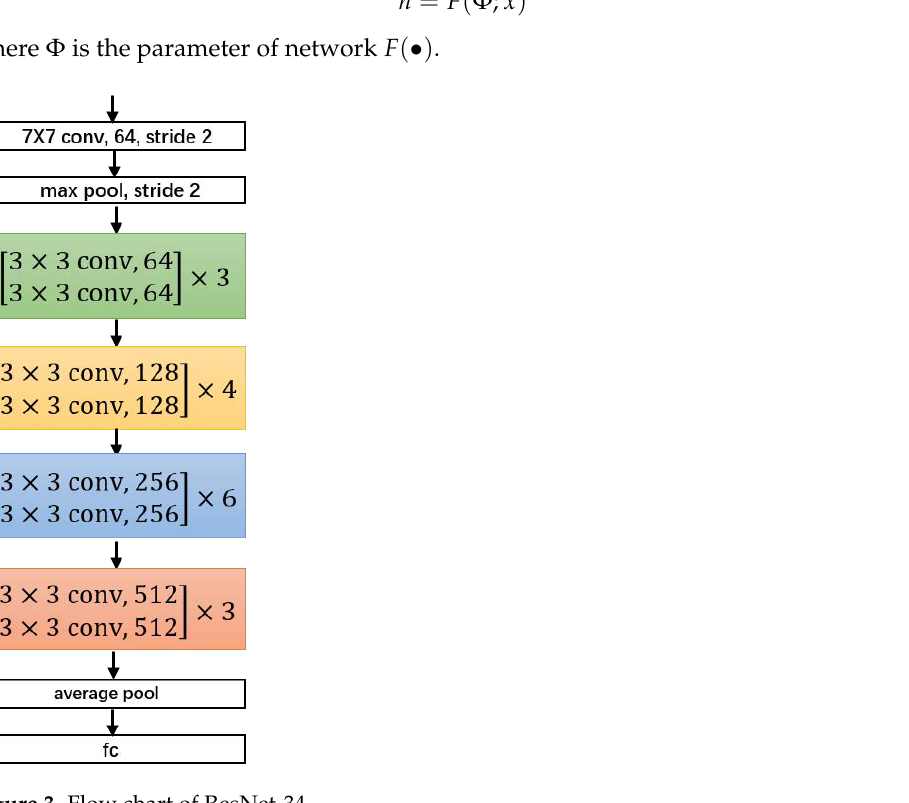
Figure 3. Flow chart of ResNet-34.